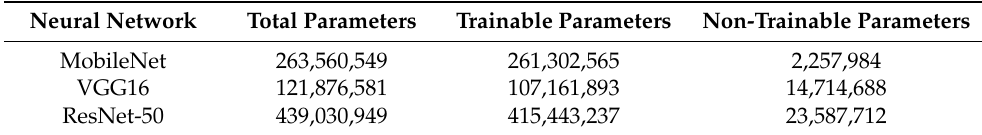
Table 1. MobileNet, VGG16 and ResNet-50 models summary.